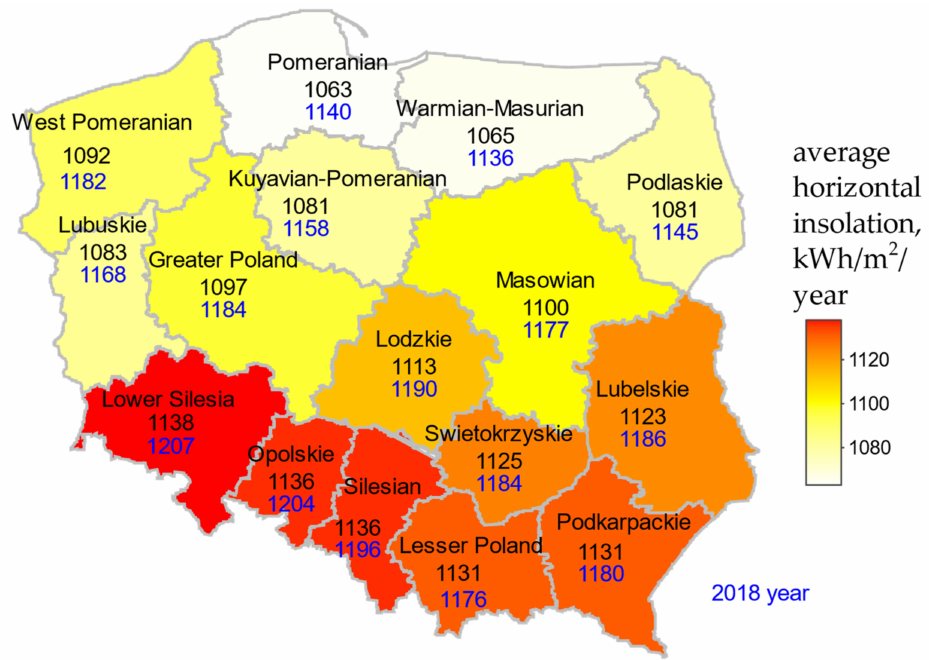
Figure 2. Horizontal insolation in Poland (for horizontal surfaces) for years: 2010–2019 (numbers in black) and 2018 (numbers in blue). Source: References